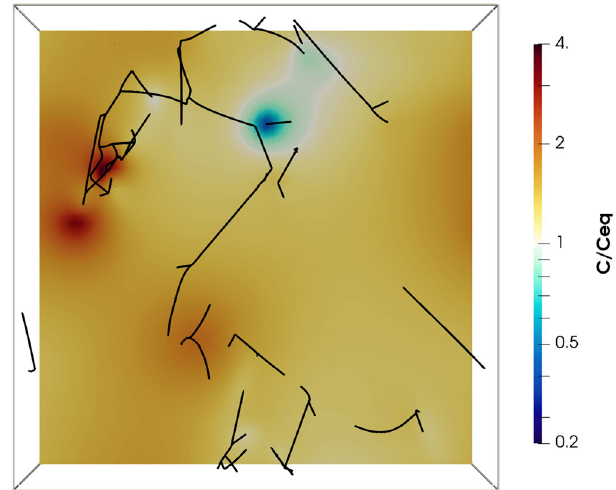
Fig. 2 Vacancy distribution around a climbing dislocation net- work at 500 C normalized to the thermal equilibrium density. Due to the exponential dependence of core density on climb force, the average concentration re fl ects a modest supersaturation.